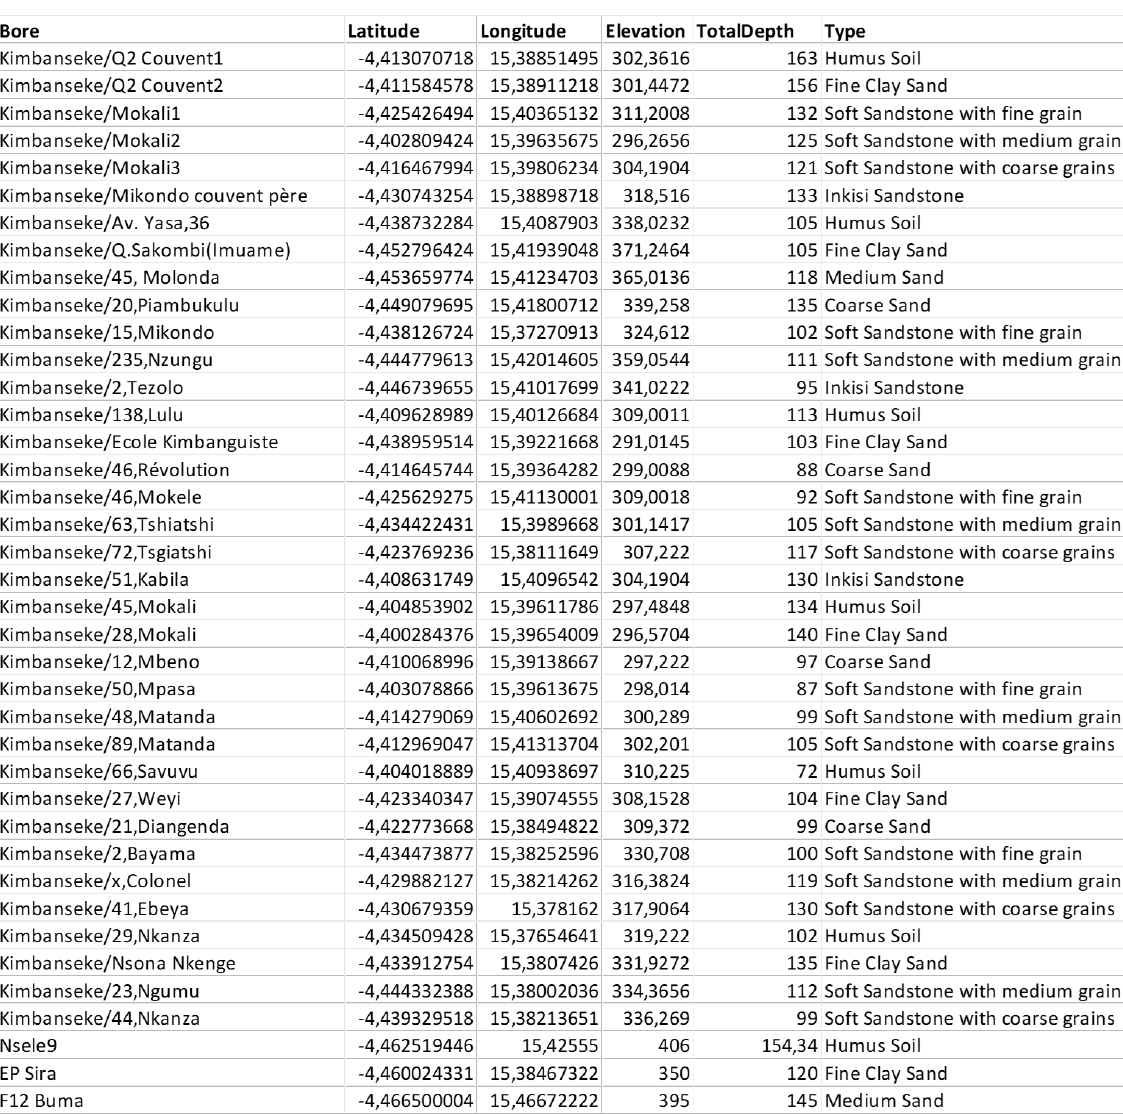
Figure A3. Borehole data.